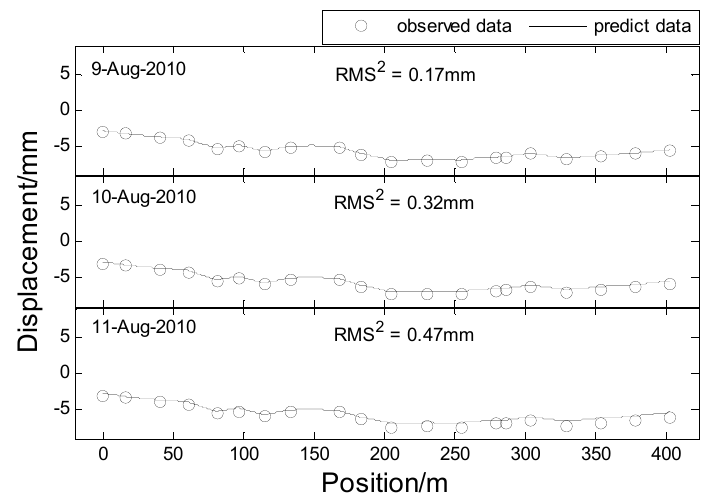
Figure 9. Equally chosen 20 days of interpolated horizontal displacement for the whole dam in the spatio-temporal domain between 24 August 2005 and 17 March 2007.